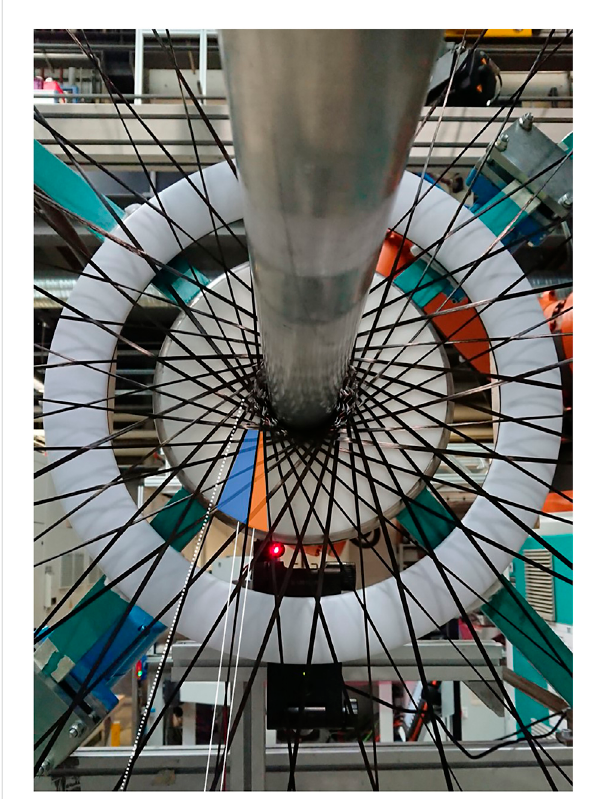
FIGURE 1 Braid formation zone during braiding with n yarn (cid:1) 64 24 k carbon yarns; curvature of one yarn indicated by a tangential white-dotted line; yarn with purposefully increased tension marked by two solid white lines; increased distance to the preceding yarn marked by blue color; reduced distance to the succeeding yarn marked by orange color; image taken from (Maidl et al., 2022) and